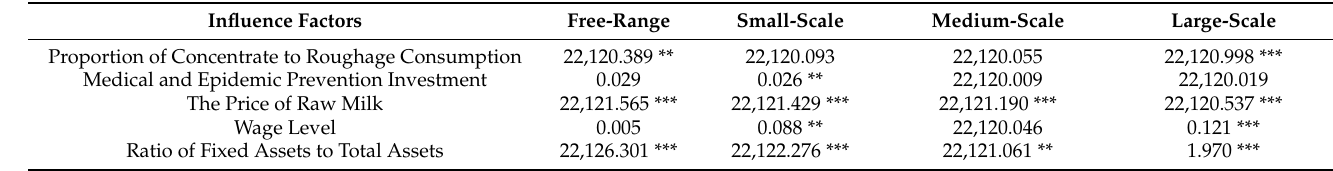
Table 9. Parameter estimation of technical inefficiency equation of three index input.